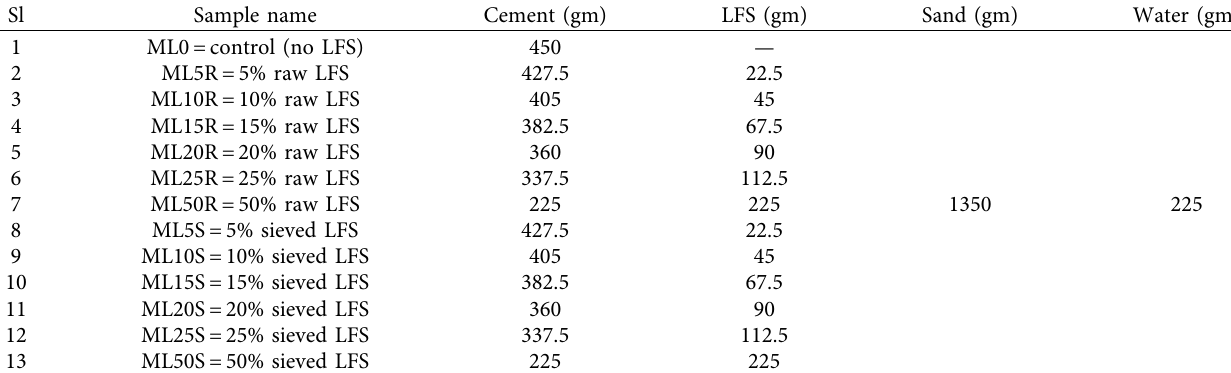
Table 1: Mix composition of mortars for a single mix in a mixer machine as adopted in this study. Sl Sample